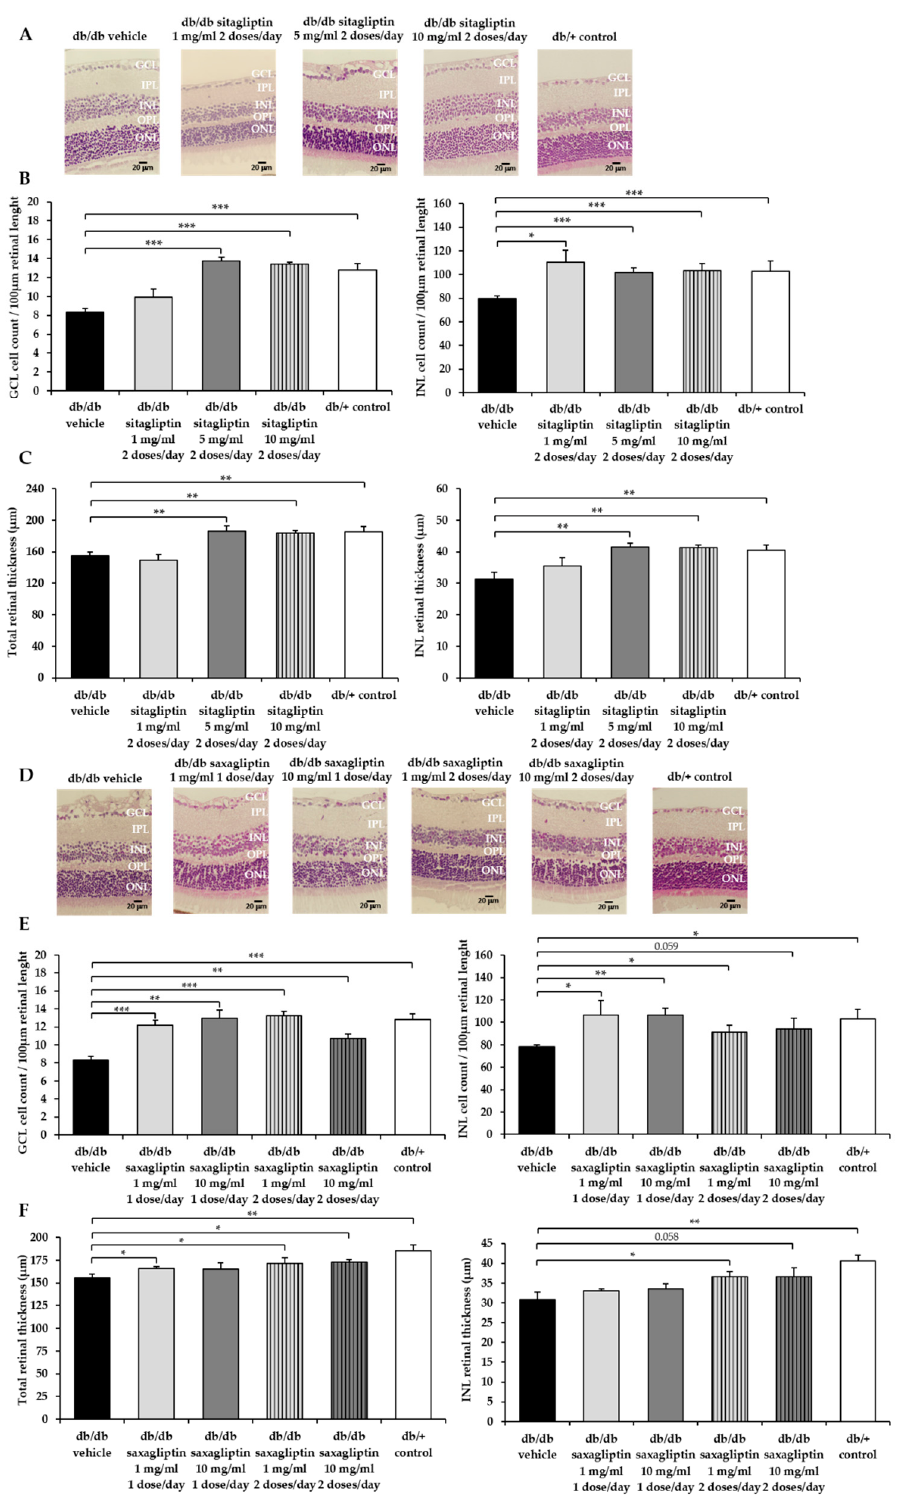
Figure 3. Cell count and retinal thinning. ( A , D ) Comparison of hematoxylin/eosin (HE)-stained retinas among representative samples of each experimental group. ONL: outer nuclear layer; OPL: outer plexiform layer; INL: inner nuclear layer; IPL: inner plexiform layer; GCL: ganglion cell layer. Scale bars, 20 µ m. ( B , E ) Quantification of the number of cells in the GCL and INL layers. ( C , F ) Retinal thickness of the INL layer and the whole retina. n = 4 mice per group and five retinal sections for each mouse. * p < 0.05; ** p < 0.01; *** p <